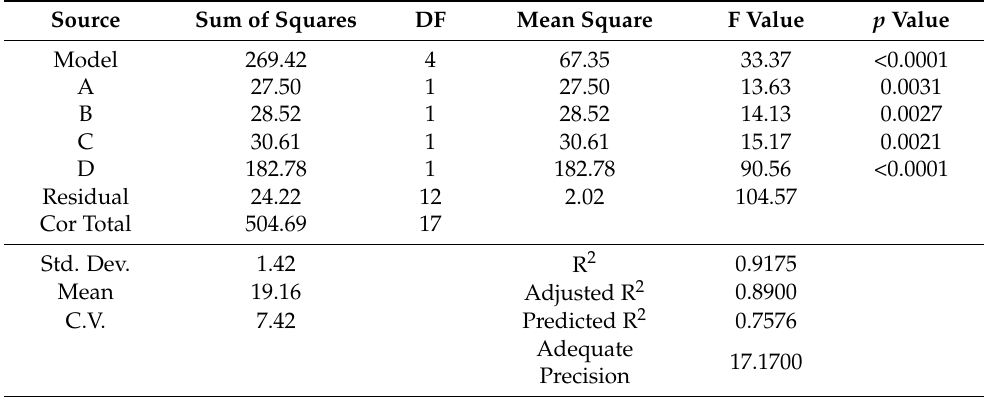
Table 4. ANOVA for the oil absorbed of the PBD model used to identify the factor significantly influencing diesel